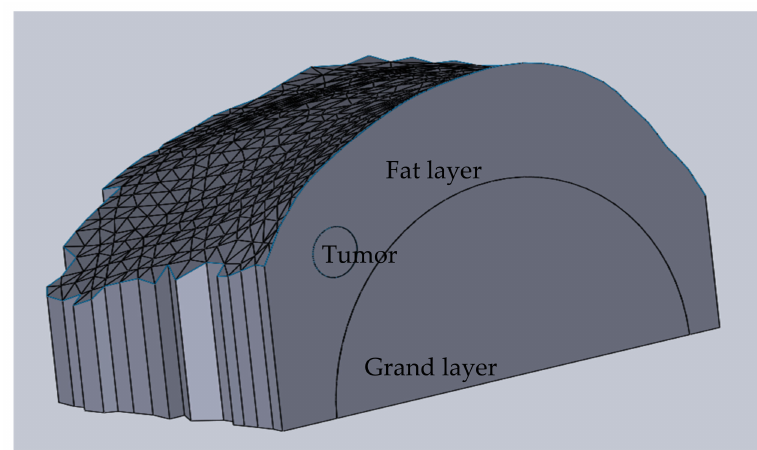
Figure 17. A 3D model with computed parameters (Patient No. 3).